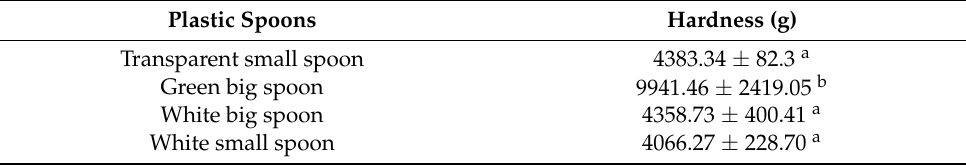
Table 2. Textural characteristics of plastic spoons.